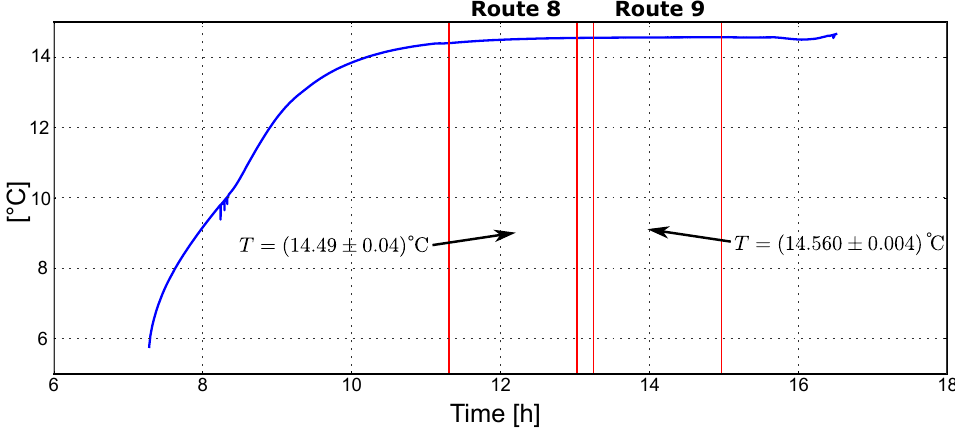
Figure 9. Temperature variation inside the sphere of the GraviMob system from the moment the AUV was launched until it was brought back on board. Once the temperature is stabilised, it remains remarkably constant at around 14.5 °C.